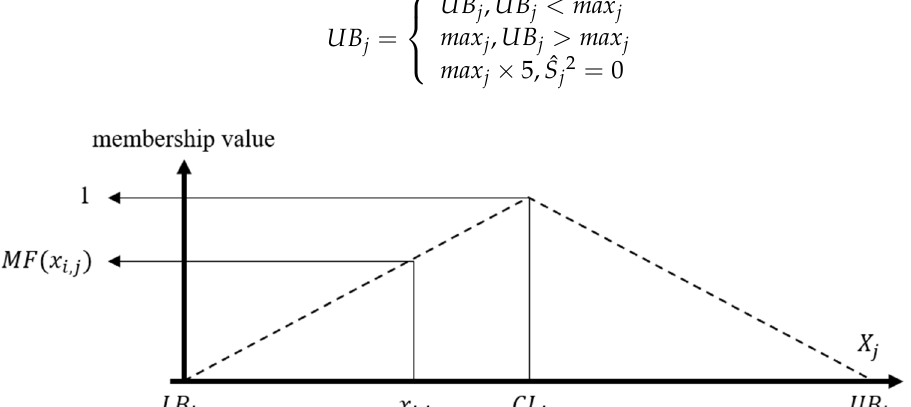
Figure 4. The membership function of MTD. The height of CL j at the midpoint of the data is set to 1 (the highest possibility of this value occurring).